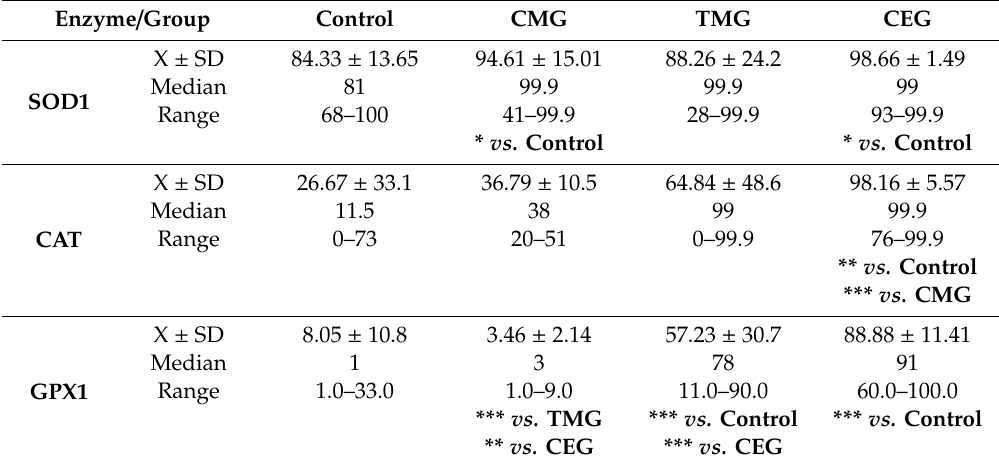
Table 2. Percentage of SOD1, CAT, and GPX1 immunopositive hepatocytes in the liver of female rats in the control, CMG, TMG, and CEG groups.